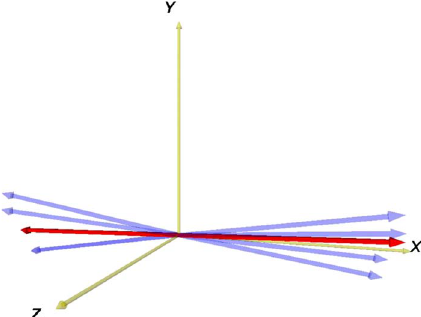
FIG. 5. (cid:1) Color (cid:2) The sum of the squared projections of the green shadows onto the green vector is maximized. The green vector pre- sents factor 2. The orange vector is perpendicular to both the red and green vectors, representing factor 3. In a general case of mul- tiple dimensions, a rotation of all factors probably is desirable and if needed can still maintain orthogonality among them.